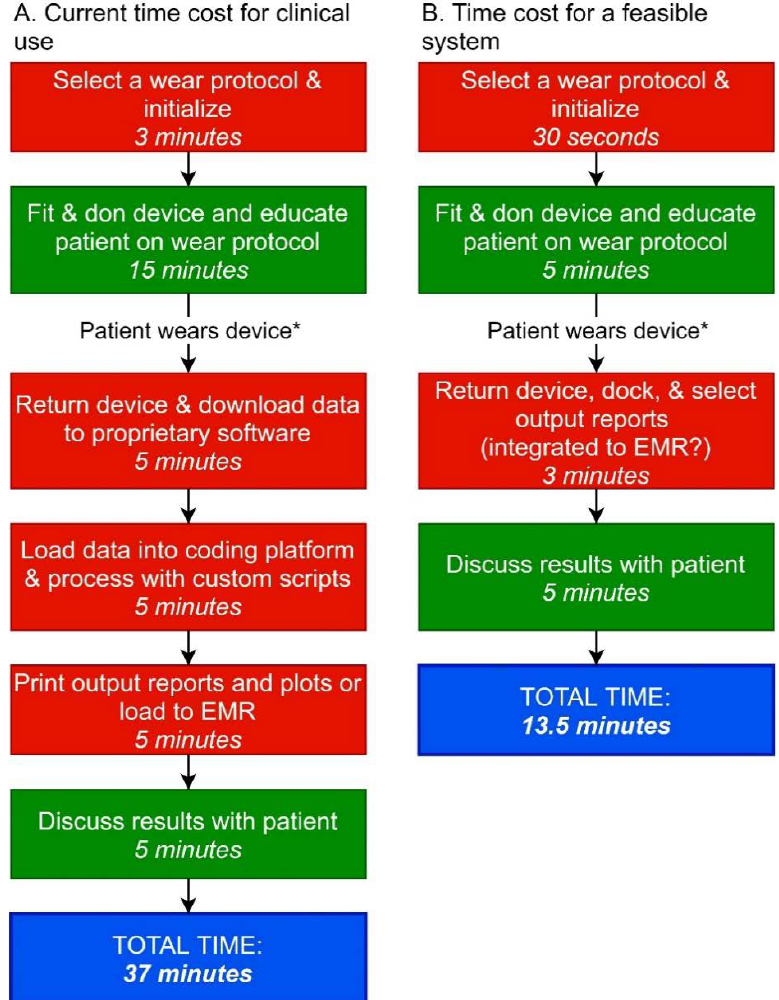
Figure 2. Time Cost for Clinical Implementation of Wearable Device Systems. A : Current time cost in clinical practice. B : Estimated time cost for realistic implementation into clinical practice. The first two boxes in A & B are estimates for an experienced clinician using a wearable device system with a new patient. Red boxes indicate non-billable time while green boxes indicate billable time. EMR: electronic medical record. * Wear time may vary from hours to several days.